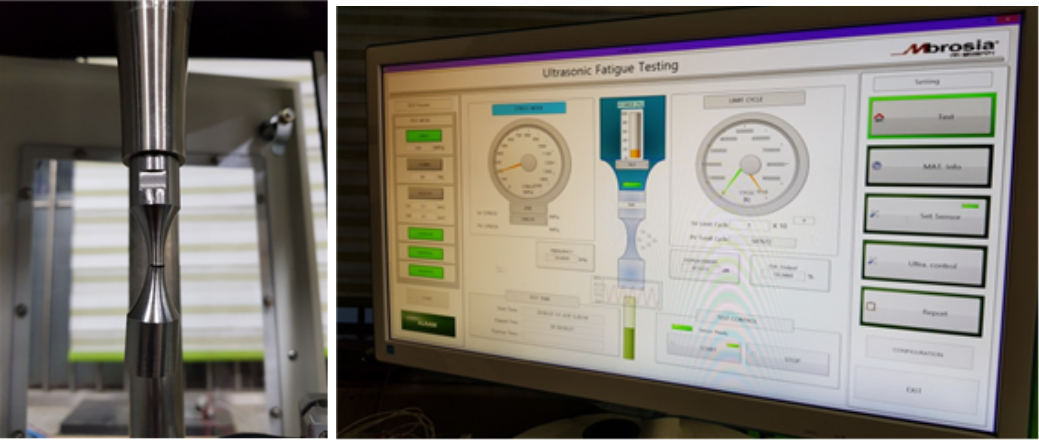
Figure 8. Ultrasonic fatigue test